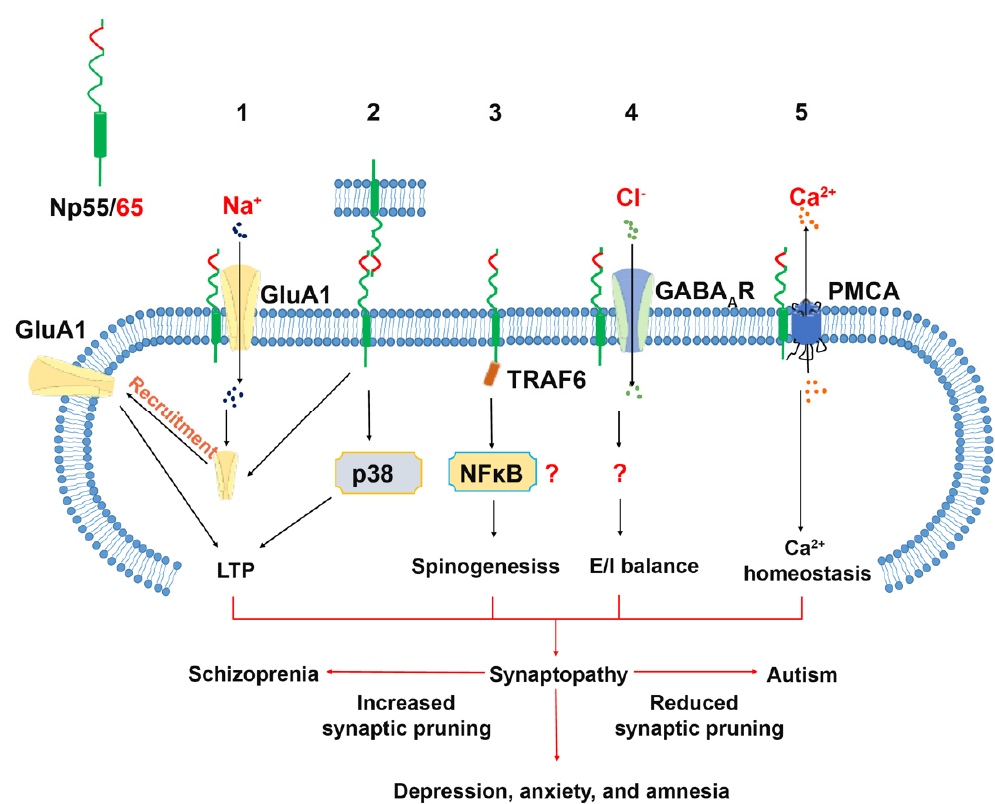
Figure 2. Neuroplastin binding proteins and their related cellular function in the central nervous system. 1. The Ig1 domain of Np65 interacts with GluA1 supporting targeting of GluA1 to the plasma membrane and is required for the LTP maintenance. 2. Neuroplastin trans-homophilic binding is involved in LTP maintenance. The binding motif resides in the Ig1 domain indicating that only Np65 can engage in this interaction. Homophilic binding of neuroplastin can be disrupted by the peptide ”enplastin”. Np55 and Np65 were proposed to bind homophilically in cis , however there are no explicit data supporting dimer formation. 3. The intracellular tail of neuroplastin contains a TRAF6 binding motif, which is important for spinogenesis. 4. Neuroplastin interacts with GABA A R. This interaction is critical for the balance of excitatory and inhibitory transmission. However, the binding domains are not identified. 5. The transmembrane domain of neuroplastin is responsible for the interaction with the plasma membrane anchor domain TM10 of PMCA which regulates the extrusion of Ca 2+ ions.